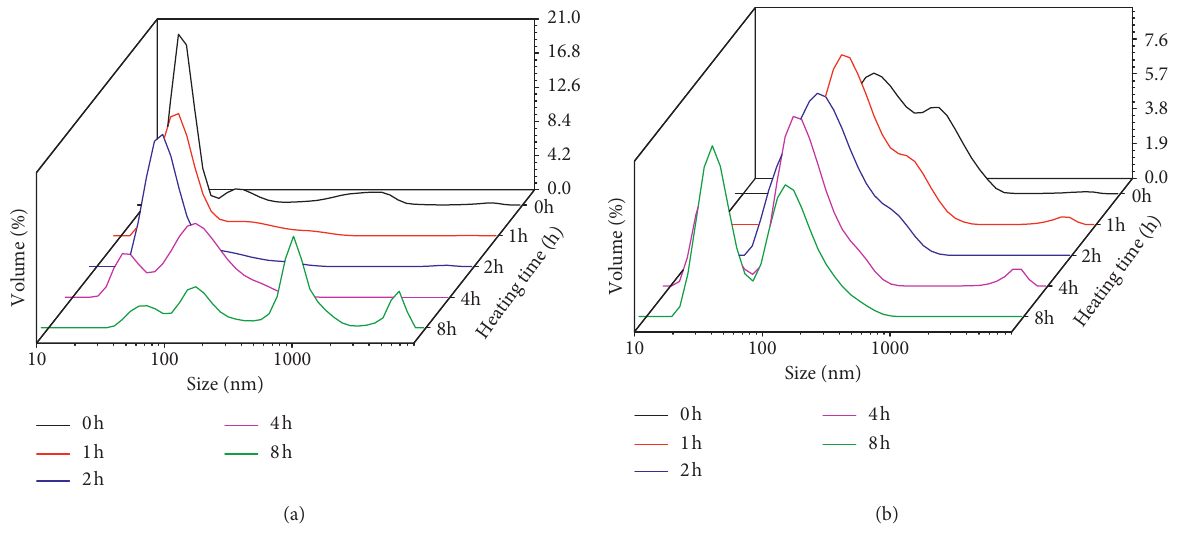
Figure 4: Particle size profiles of SPIN (a) and SPIHN (b).